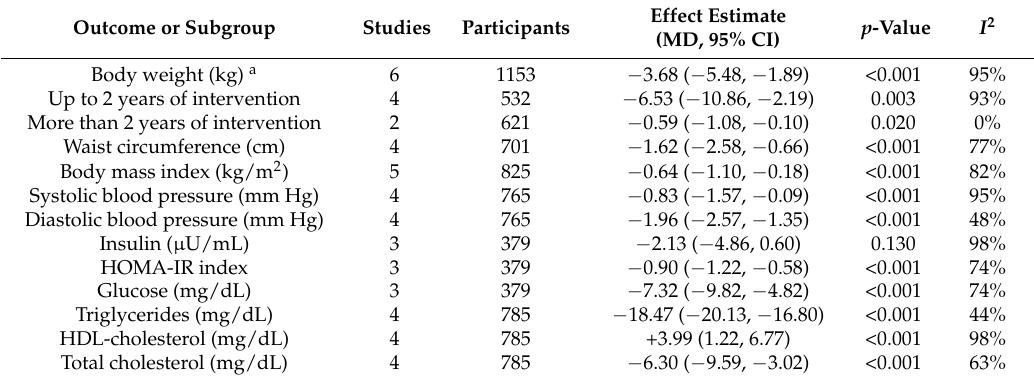
Table 2. Combined effect of the Mediterranean diet and physical activity on metabolic risk